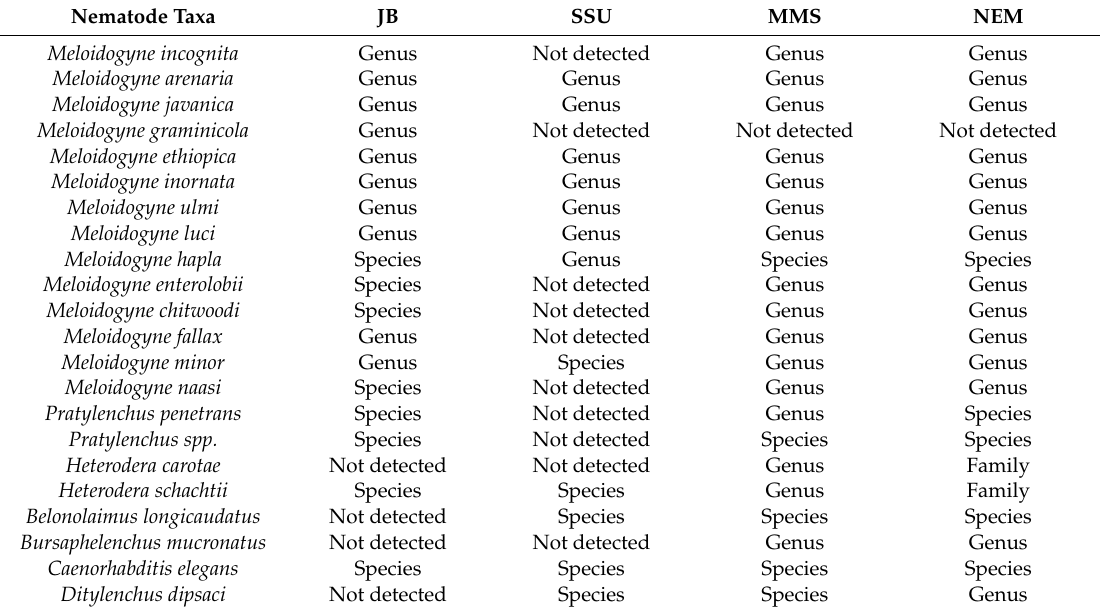
Table 1. The e ffi ciency of four metabarcoding primer sets in the detection of individual nematode taxa at di ff erent taxonomic ranks using Illumina